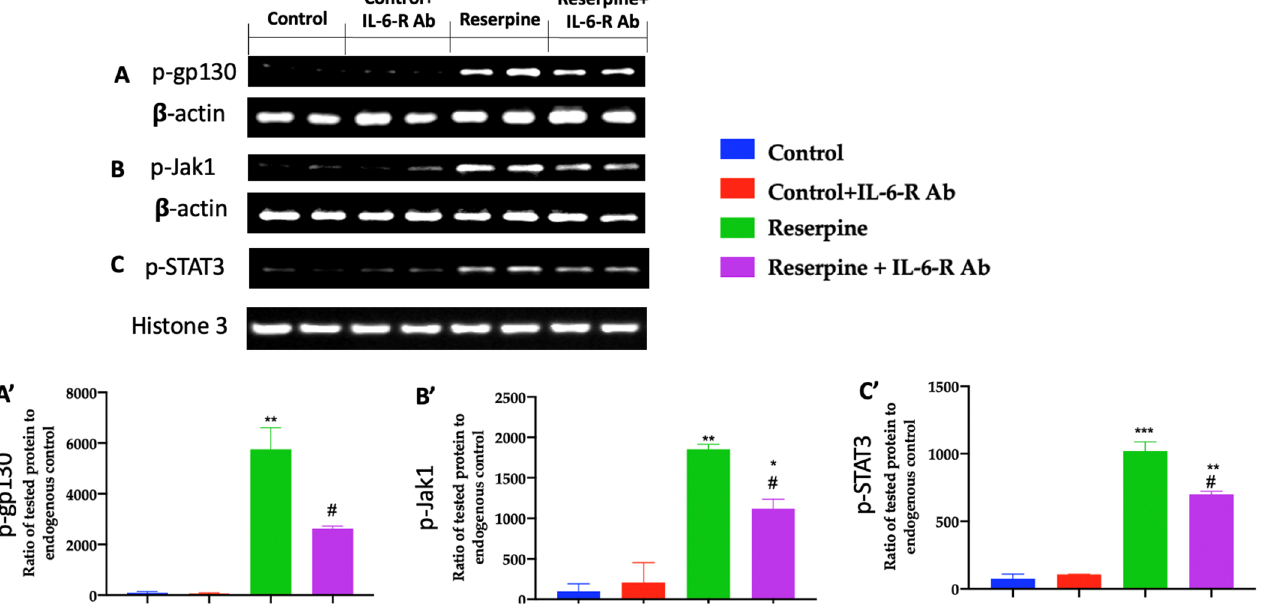
Figure 5. Effect of IL-6-R Ab on pain-related mediators: Western-blot analysis of: ( A , A’ ) p-gp130, ( B , B’ ) p-Jak and ( C , C’ ) p-STAT3